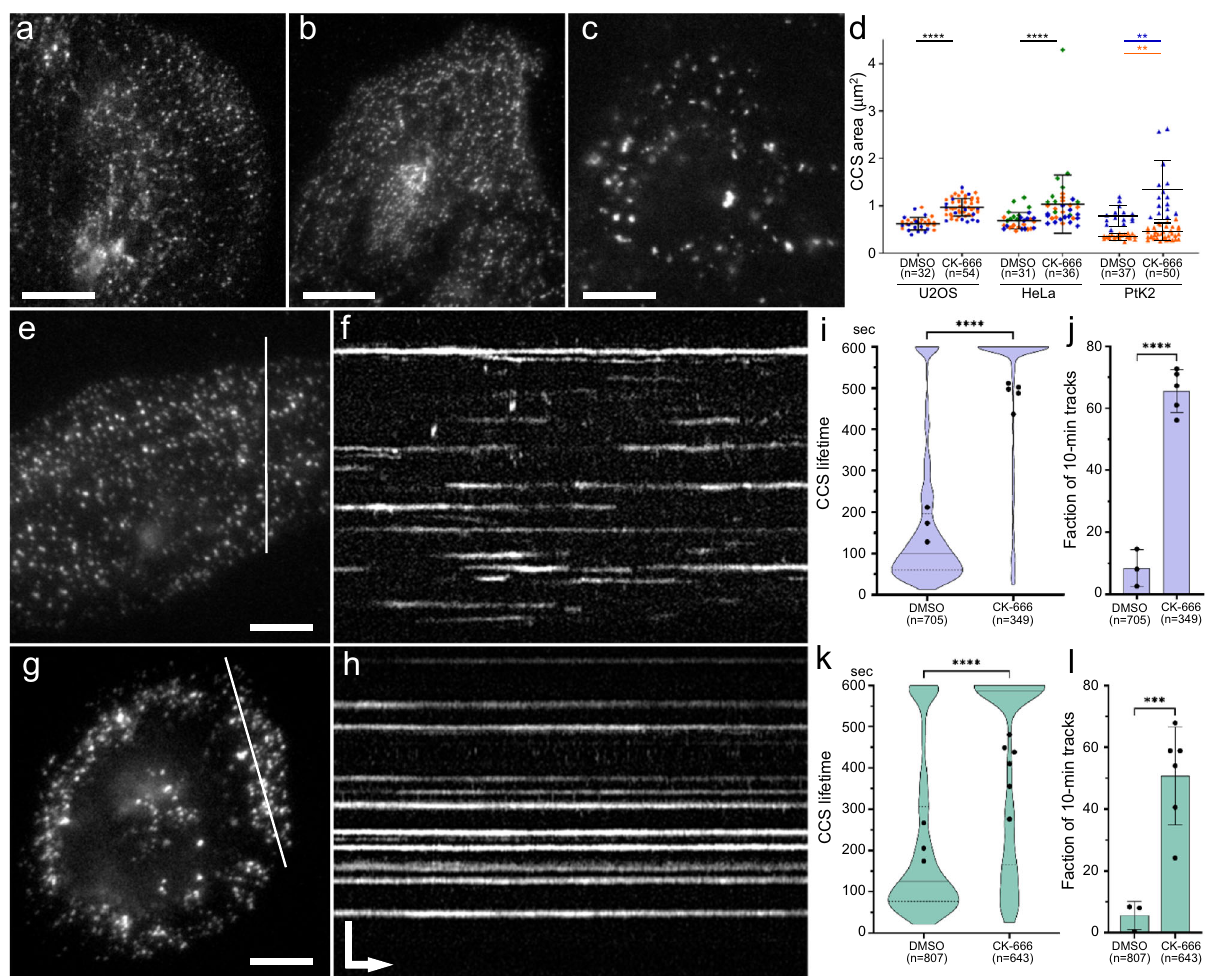
Fig.4|InhibitionoftheArp2/3complexleadstoenlargementandstabilization of CCSs in intact cells. a – c TIRF microscopy images of RFP-CLC in U2OS cells cultured in the presence of 10% FBS ( a ), or incubated overnight in a medium containing 0.1% FBS and supplemented for the last 4h with either DMSO ( b ) or 200 μ M CK-666 ( c ). d Quanti fi cation of the CCS areainTIRFmicroscopyimages of the indicated cell types treated with either DMSO or 200 μ M CK-666, as described for b and c . Individual experiments are color-coded. CCSs were visualized using endogenously tagged RFP-CLC (U2OS and HeLa cells) or by immunostaining of CHC(PtK2cells; individualexperiments werestatisticallyevaluatedseparately due todifferentstainingintensities).Errorbars,mean±SD;**** p <0.0001;** p =0.0049 (blue) or 0.0043 (orange); (unpaired two-tailed t test with Welch ’ s correction); n, number of cells. e , g First frames of 10-min long TIRF microscopy time-lapse